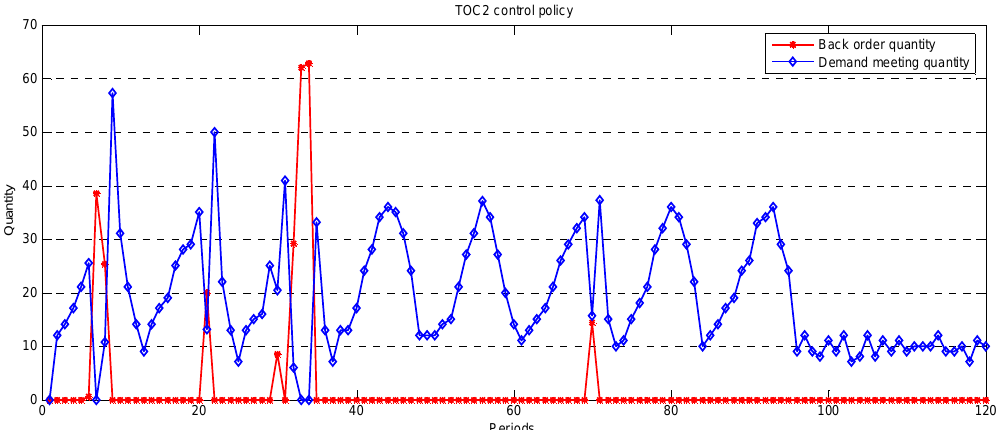
Fig.11. Back order and Demand meeting curve of TOC2 control policy